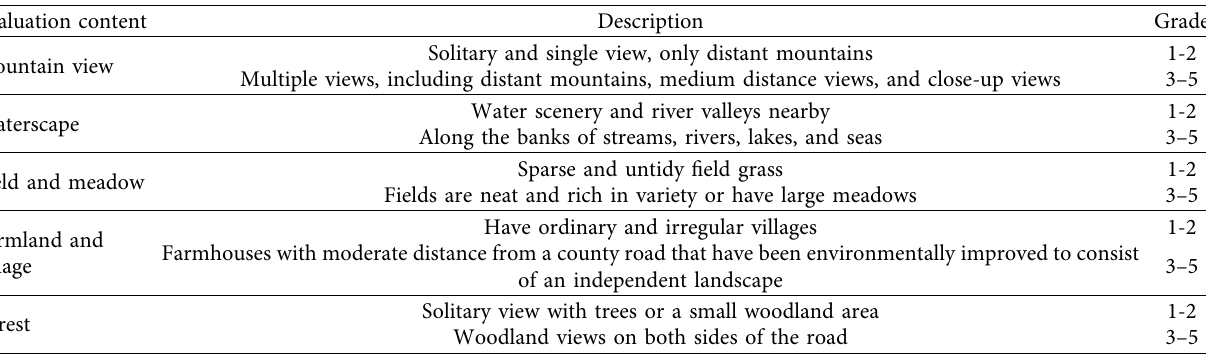
Table 2: Rural scenery evaluation index and grading standard.